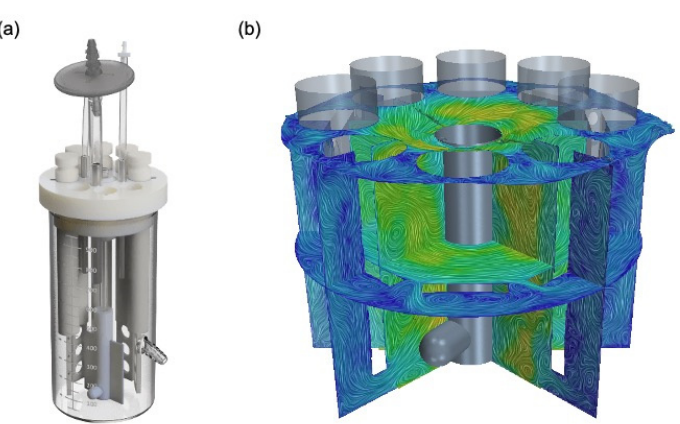
Figure 1. The CDC biofilm reactor ( a ) with the CAD representation of the fluid geometry ( b ) and showing the liquid phase velocity on four cross-section planes at approximately 15.5 s into the sim- ulation.